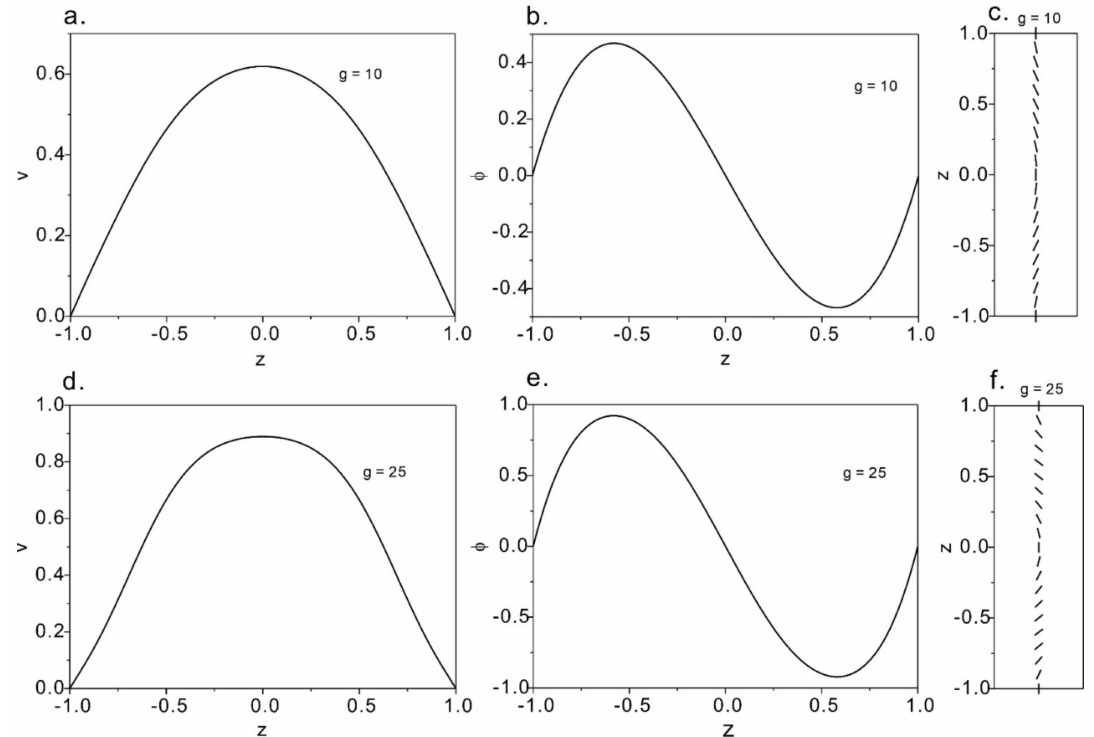
Figure 6. Velocity profiles and director fields at strong anchoring condition. ( a – c ): The solution of strong anchoring at g = 10. ( a ) Velocity distributions over the channel width; ( b ) angle of the director; ( c ) director distributions over the microchannel. ( d – f ): Director and flow distributions within the microchannel under the pressure of g = 25.